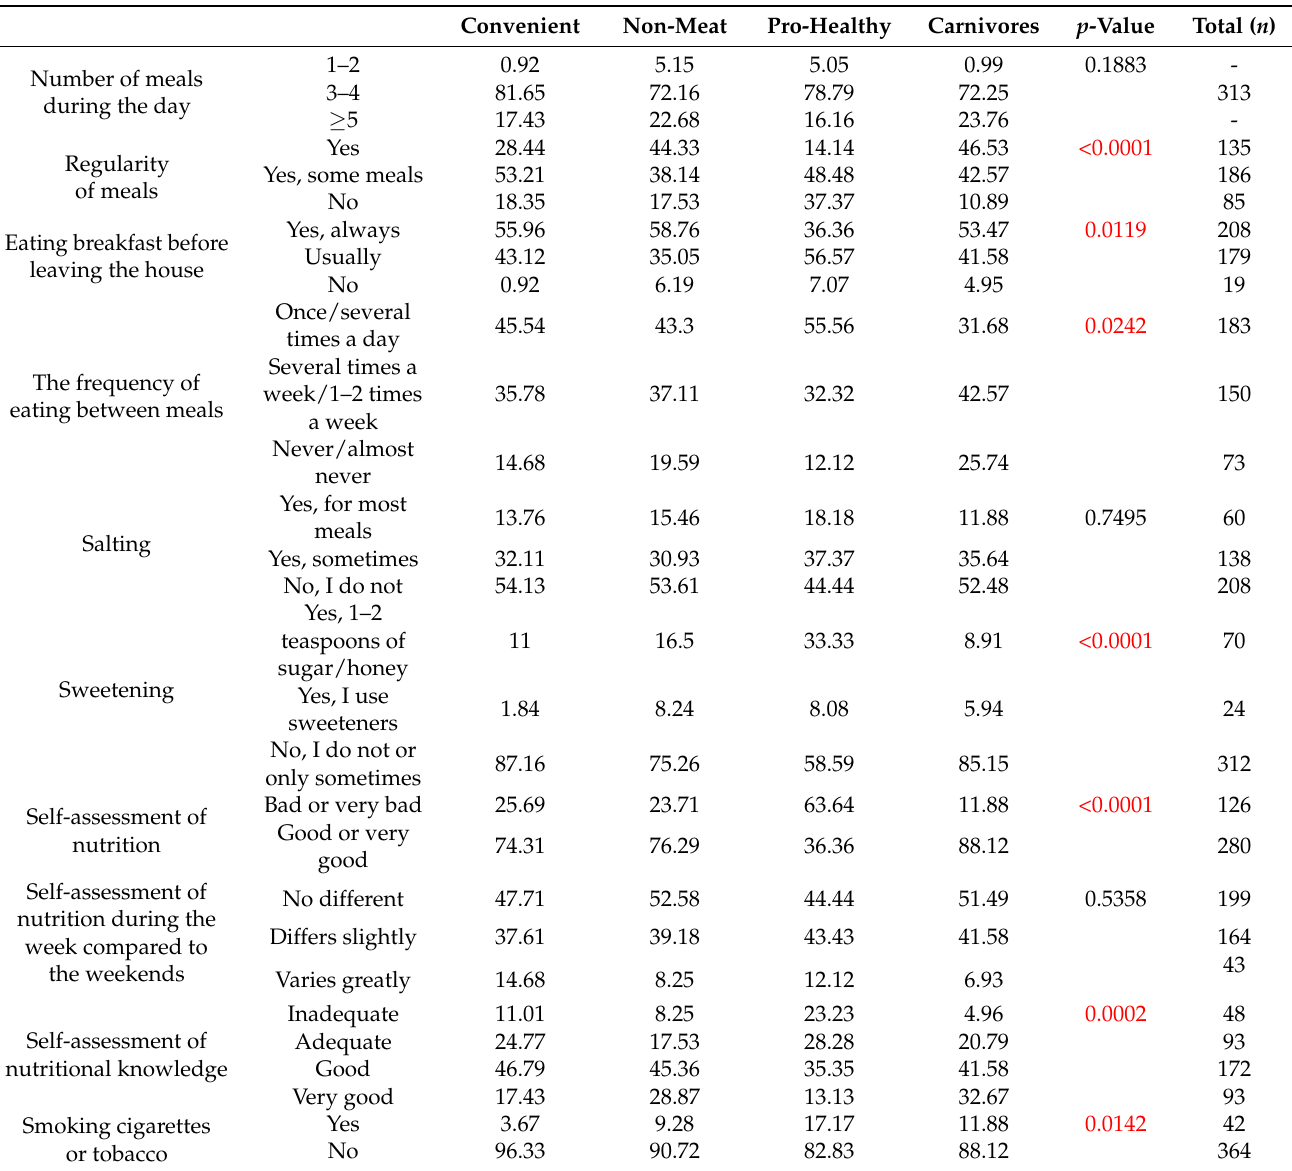
Table 5. Characteristics of the respondents by nutritional behavior, nutritional knowledge, smoking, and dietary pat- terns